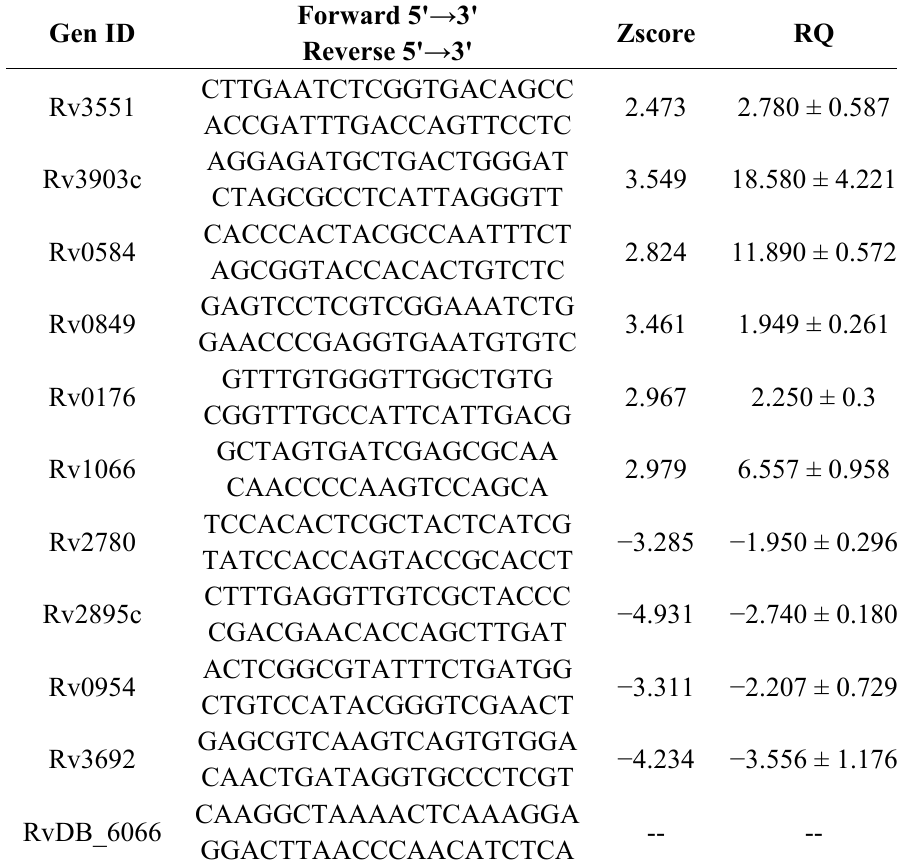
Table 2. Selected genes from microarray analysis, designed pair of primers for them and its validation by quantitative